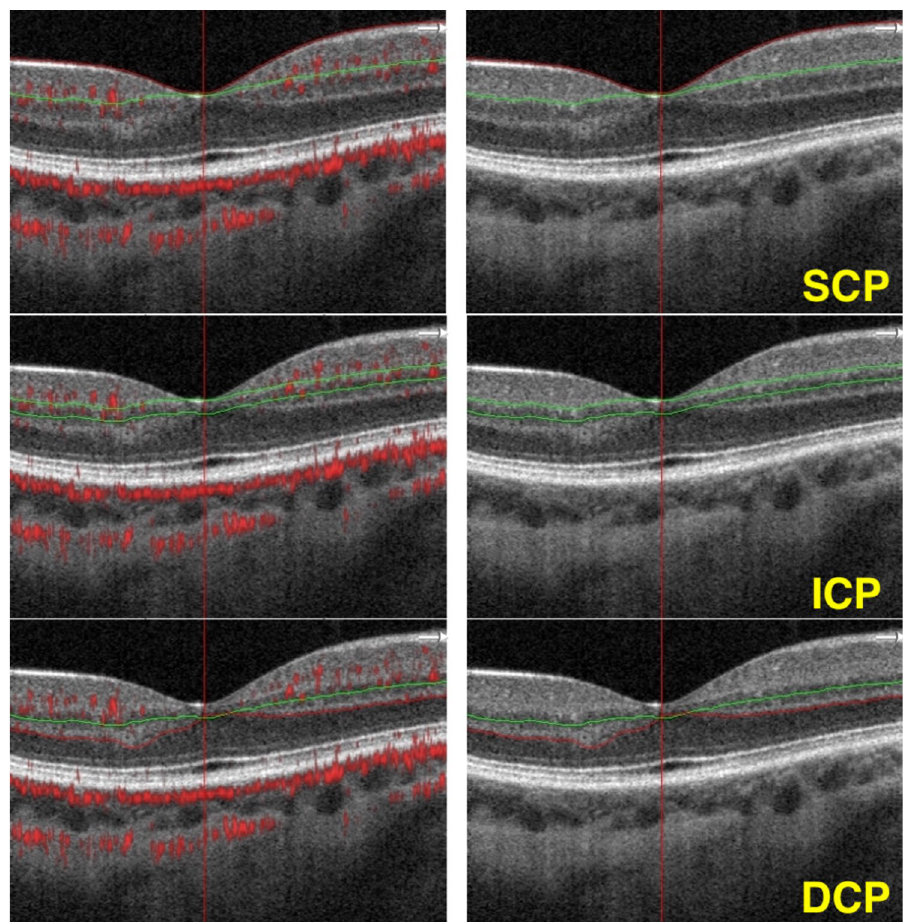
Figure 1. Optical coherence tomography B-scans showing the retinal segmentation in different capillary plexuses. Superficial capillary plexus (SCP): boundaries segmented from the internal limiting membrane (red line) to 10 μm above the inner plexiform layer (green line). Intermediate capillary plexus (ICP): boundaries (green lines) segmented from 10 μm above to 30 μm below the inner plexiform layer. Deep capillary plexus (DCP): boundaries segmented from 30 μm below the inner plexiform layer (green line) to 10 μm below the outer plexiform layer (red line). All images come from the same eye of a single subject. Images were